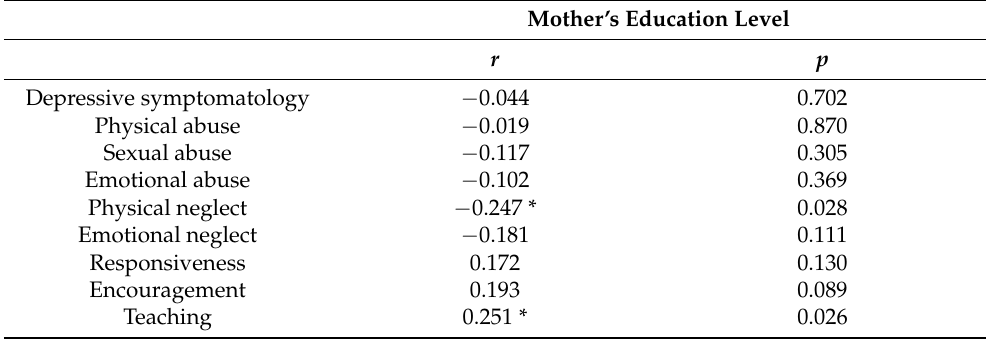
Table 4. Correlations between the mothers’ education level and the reported childhood trauma and depressive symptomatology